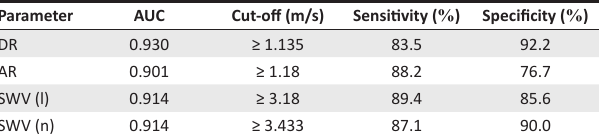
TABLE 3: Cut-off values and diagnostic performance of individual elastography